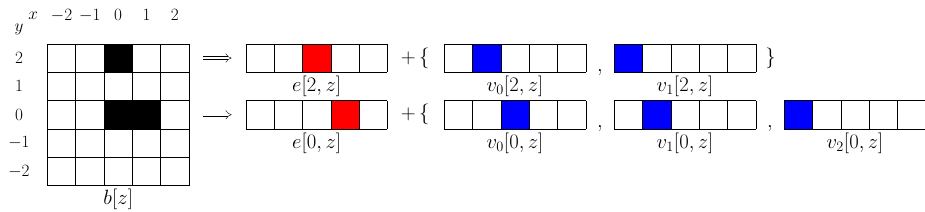
Figure 3: Example of pattern that cannot be forward extended in the kernel. For each active row of slice b [ z ], offset and basis vectors for the space of χ -compatible rows are depicted in the format “offset + { basis vectors } ”. Basis for row y = 2 has no basis vector with active bit in x = 1 to complement the offset at row y = 0. Thus, since no offset in the kernel can be constructed, the pattern cannot be extended in the kernel.